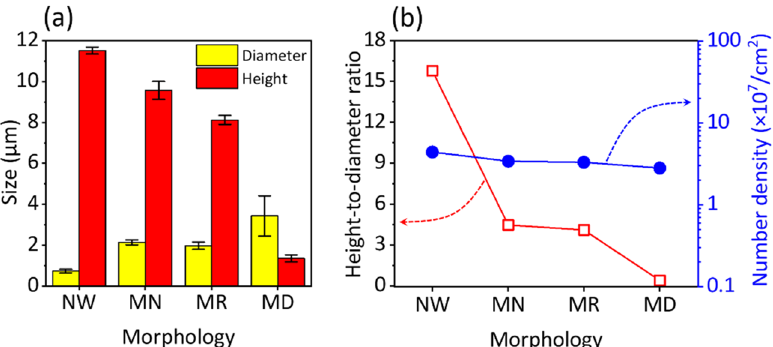
Figure 2. Morphological information of ZnO grown by the remote epitaxy. ( a ) Mean diameter (yellow columns) and height (red columns) values. The diameter of NW, MN, MR, and MD was measured at 0.73 ± 0.09, 2.14 ± 0.12, 1.98 ± 0.18, and 3.44 ± 0.99 µm, respectively; the height of those was at 11.52 ± 0.17, 9.57 ± 0.44, 8.13 ± 0.22, and 1.36 ± 0.17 µm. Error bars represent ± standard deviation values. ( b ) h / d ratios (red empty squares) and number density (blue filled circles) for different ZnO